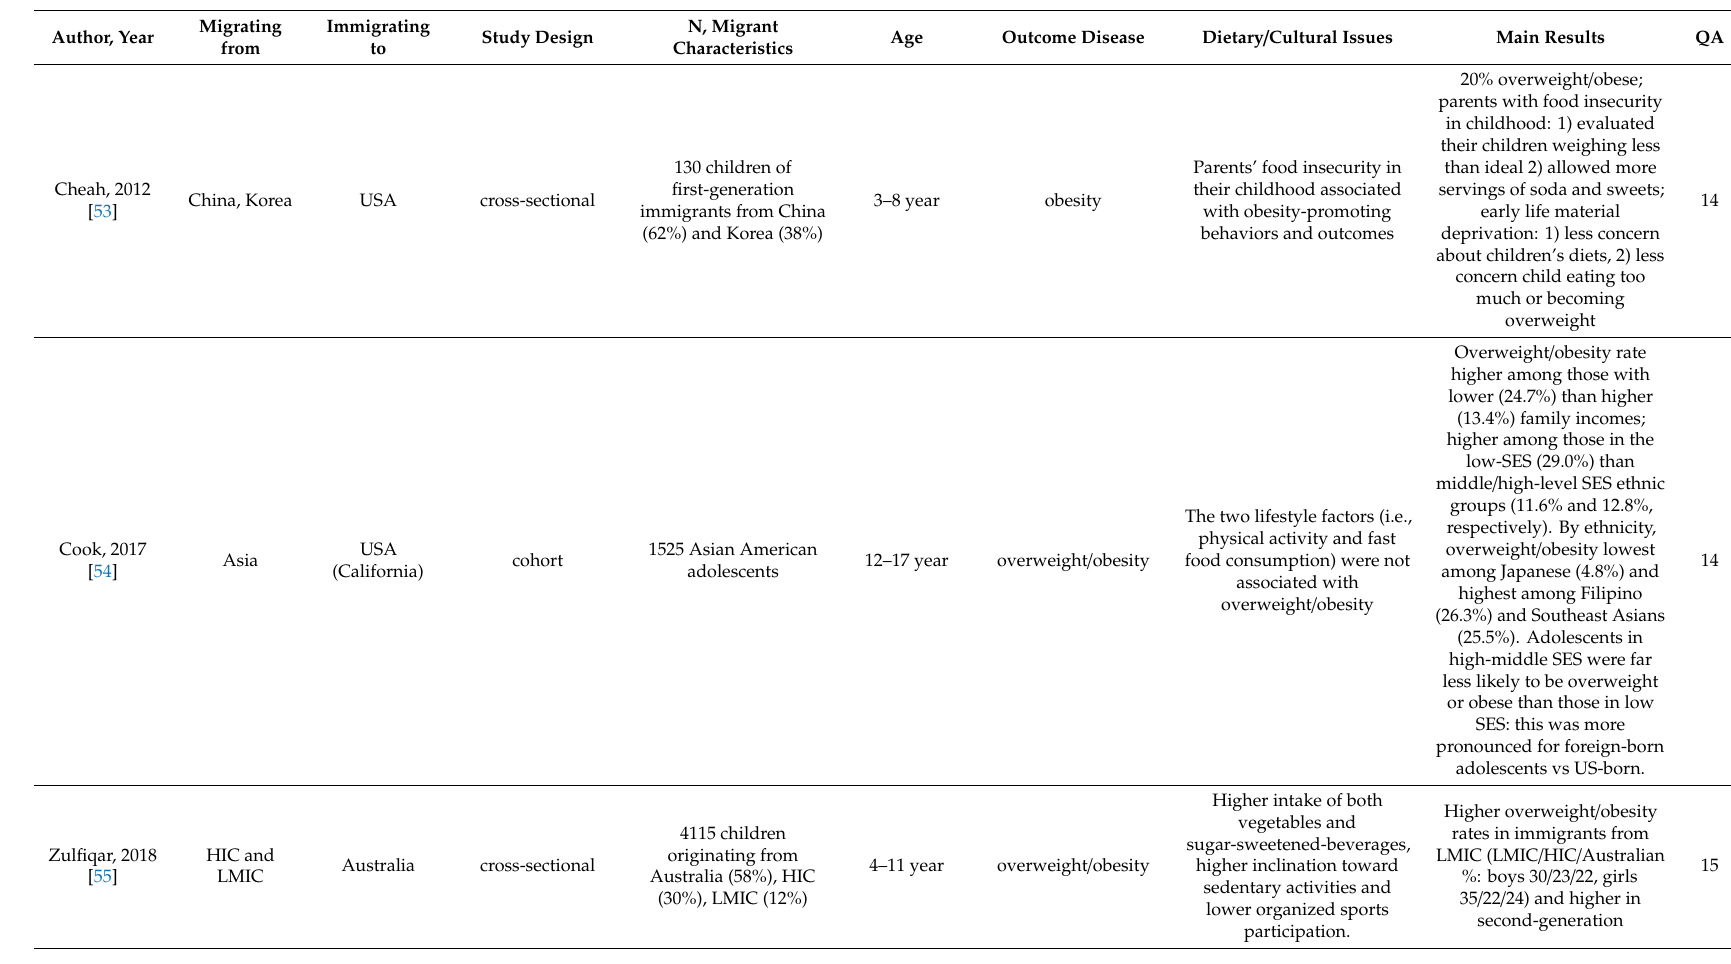
Table 5. Characteristics and main results of the included studies.